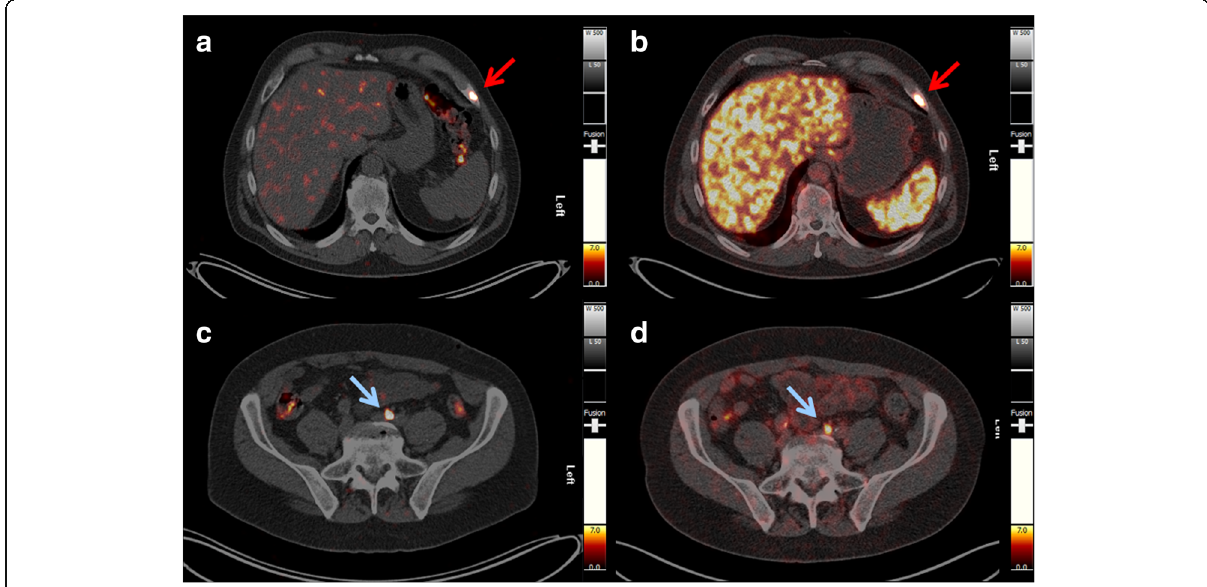
Fig. 6 Comparison of PET/CT scans obtained with 152 Tb-PSMA-617 and 68 Ga-PSMA-11, respectively. a , c PET/CT image acquired 18.5 h after injection of 140 MBq of 152 Tb-PSMA-617. b , d PET/CT image acquired 45 min after injection of 160 MBq of 68 Ga-PSMA-11. Red arrows show a bone metastasis in the ventrolateral part of the left 7th rib, and blue arrows show a small lymph node metastasis along the left common iliac